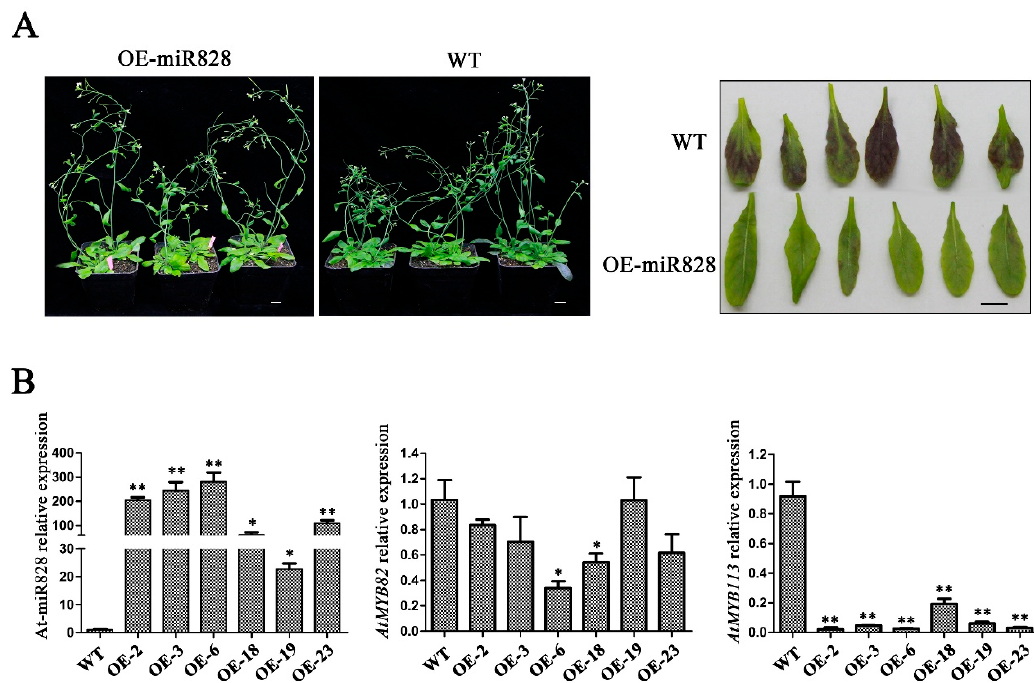
Figure 10. Phenotypic characterization of wild type and transgenic Arabidopsis. ( A ) Image of wild type (WT) and transgenic Arabidopsis and images of the back of rosette leaves of wild type (WT) and transgenic plants. Scale bar: 1 cm. ( B ) Expression levels of ath-miR828 detected by step-loop qRT-PCR and its target genes. * p < 0.05 and ** p < 0.01 respectively, according to two-tailed Student’s t -test. Error bars show the standard error between three biological replicates ( n = 3).